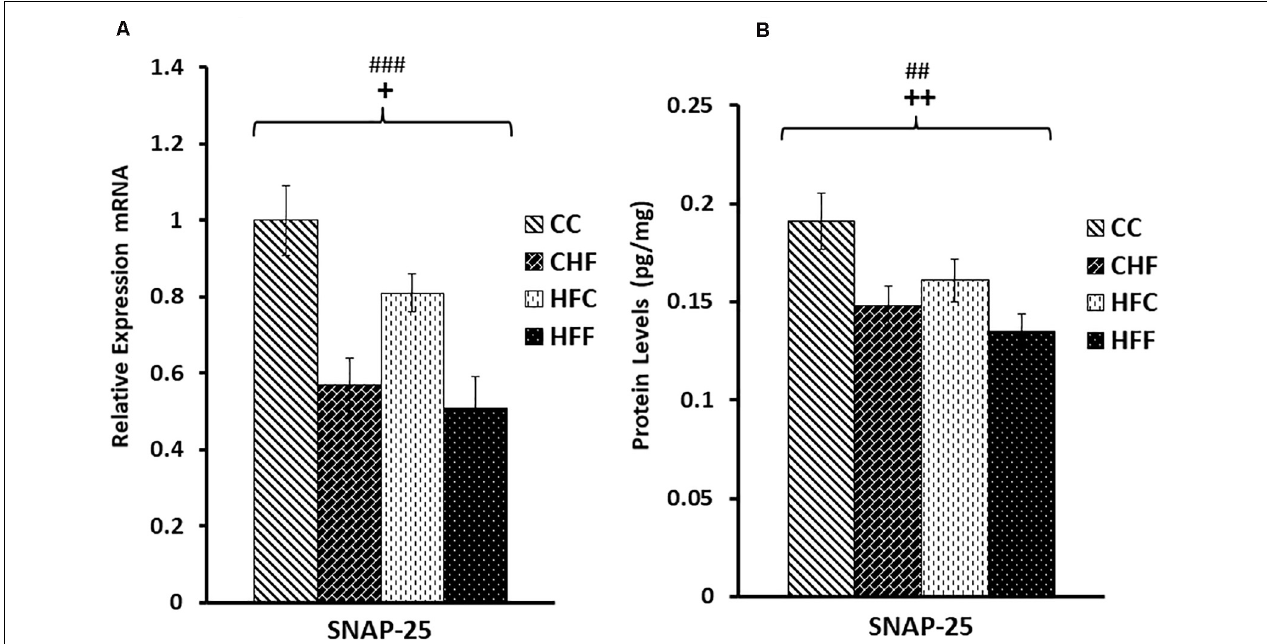
FIGURE 5 | Relative levels of SNAP25 mRNA and protein expression in the hippocampus. (A) Using qRT-PCR, hippocampal synaptosomal-associated protein 25 (SNAP25) mRNA expression was significantly reduced in response to both maternal ( F ( 3 , 57 ) = 5.11, P = 0.038) and post-weaning high-fat diets (post-weaning diet effect; F ( 3 , 57 ) = 12.71, P = 0.001). Values are expressed in relative units where CC group is set to 1. (B) Significant reduction in SNAP25 protein levels (pg/mg) was also detected in response to both the maternal ( F ( 3 , 57 ) = 8.36, P = 0.007) and post-weaning HF diets ( F ( 3 , 57 ) = 10.53, P = 0.003) using ELISA. No significant interactions were detected using two-way ANOVA. Values are means + SEM ( n = 16 for each group). + P < 0.05, ++ P < 0.01 (significant maternal diet effect); ## P < 0.01, ### P < 0.001 (significant post-weaning diet